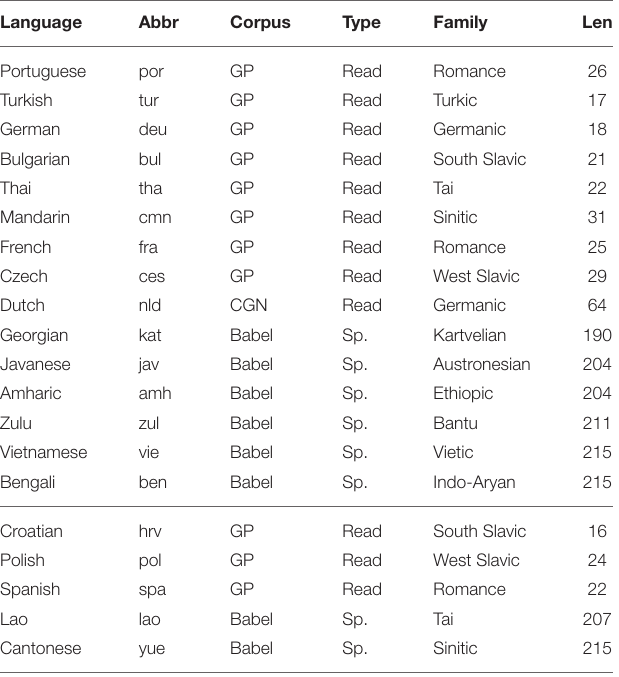
Table 2 lists phone token error rates (PTER, %) of an ASR trained using 15 languages, and tested on five additional languages. The 15 training languages were chosen to span 10 language families; the five test languages were chosen to be members of five of the same families. Parameters of the ASR were trained using training data in the 15 languages shown in the left column. Each neural network was trained until PTER reached a minimum on development test data in the 15 training languages (a strategy sometimes called early stopping Prechelt, 1998). Other hyperparameters, including multi-task training weights